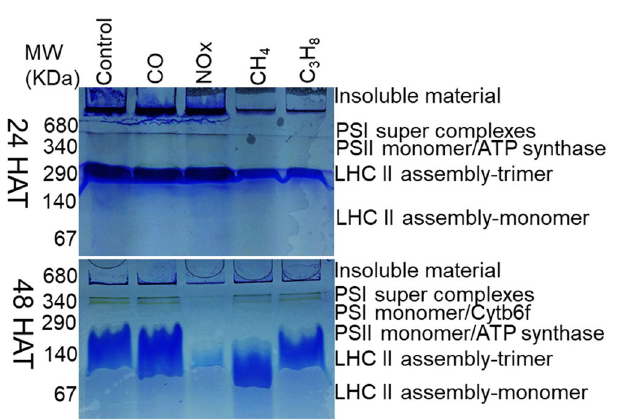
Figure 5. Analysis of thylakoid protein complex by BN-age as affected by CO, NO x , CH 4 and C 3 H 8 for 24 and 48 hours after treatment. Freshly thylakoid membranes from mature leaves were solubilized in 1% BDM at chlorophyll concentration of 1 µ g µ l − 1 , and the protein sample was separated by 7–10% gradient BN-PAGE.